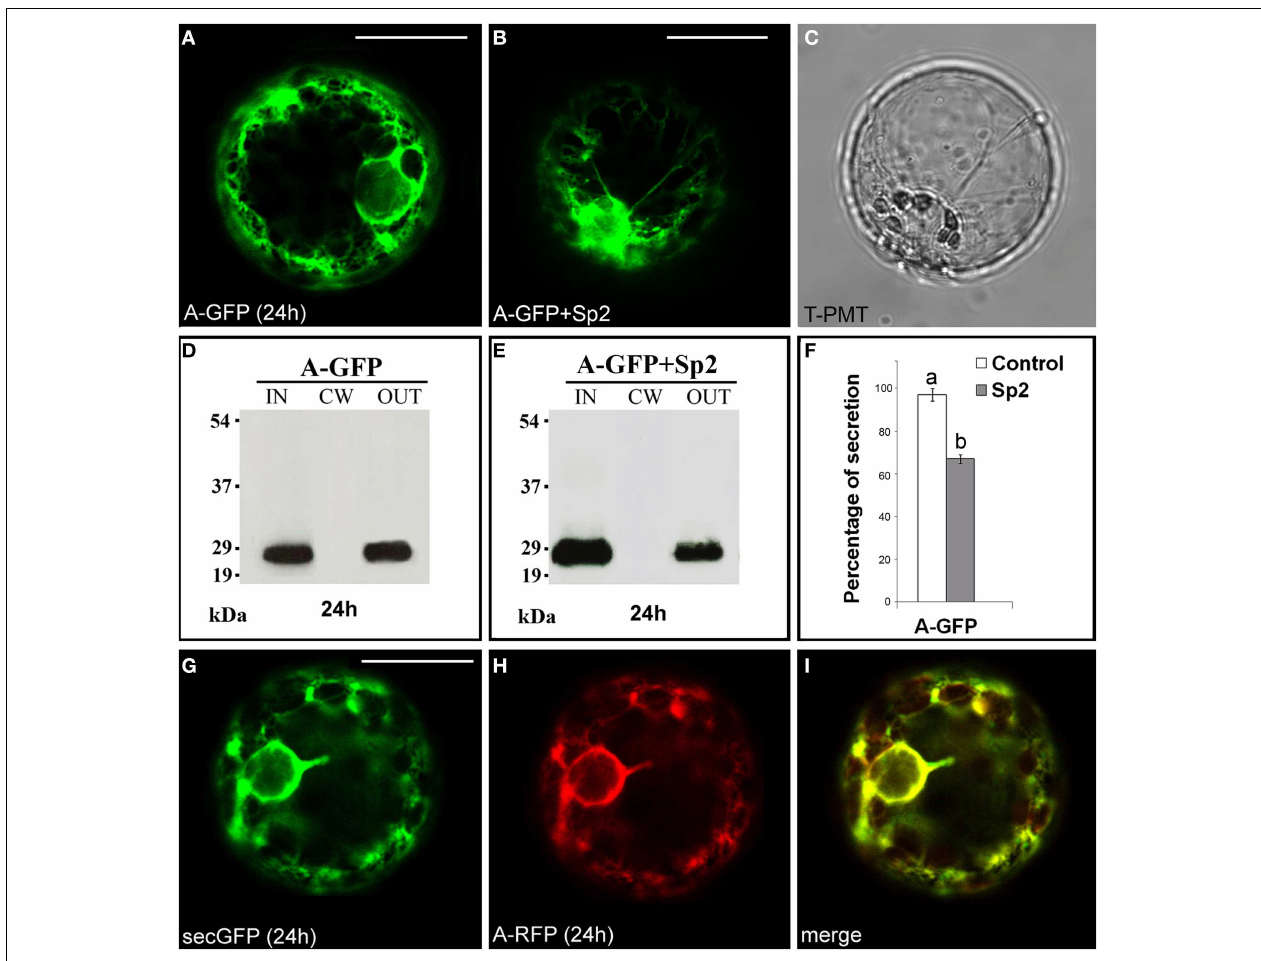
FIGURE 1 | Transient expression of A-GFP in tobacco protoplasts. (A) A-GFP labeled the endomembrane system and (B) accumulated within protoplast in the presence of Sp2. (C) Transmitted light detector (T-PMT) image of (B) . (D) Western blot of proteins obtained from the intracellular (IN), cell wall (CW) and incubation medium (OUT) fractions of A-GFP-expressing protoplasts. (E) Western blot showing the effect of Sp2 on A-GFP secretion. Bands were detected using an anti-GFP serum. (F) Quantification of the effect of Sp2 co-expression on the secretion of A-GFP. Data are means ±